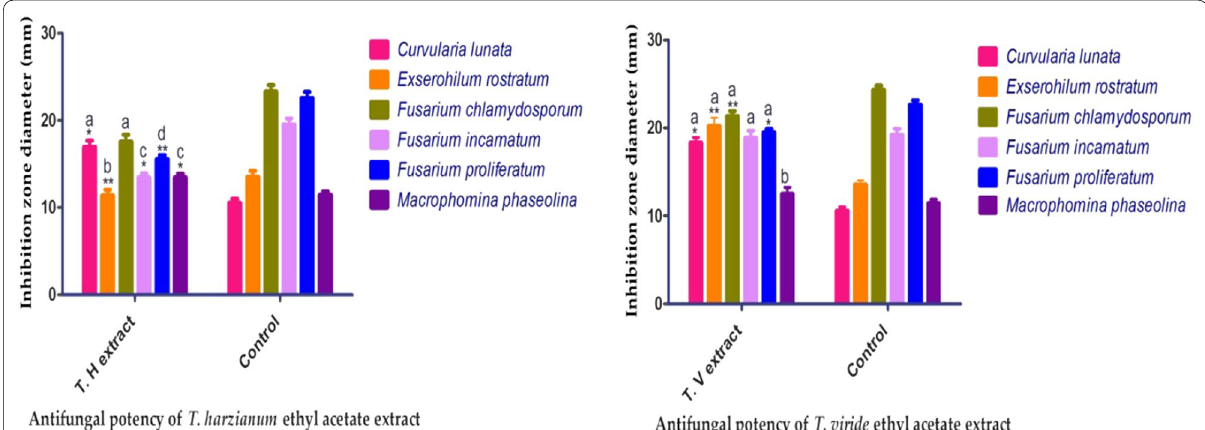
Fig. 4 Antifungal activity of the ethyl acetate extracts of T. viride and T. harzianum against different fungal phytopathogens.*Asterisks indicate that the antifungal efficacy of the extracts was significantly different compared with that of the control (Terbinafine) (** P letters indicate that values are significantly different ( P